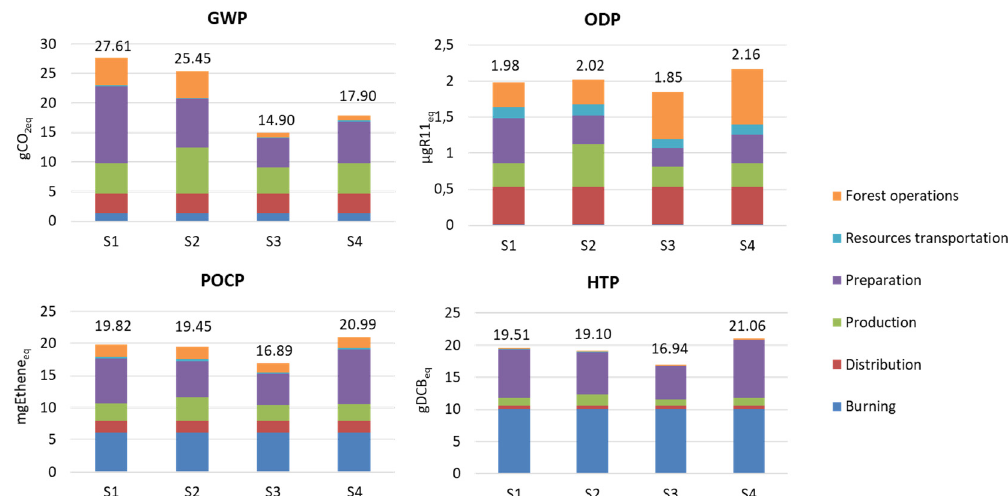
Figure 3. Specific environmental impacts for all four pellet supply chains (S1: pellets from sawmill sawdust; S2: pellets from roundwood; S3: pellets from whole trees, S4: pellets from logging residues) grouped per impact category (GWP: Global Warming Potential, ODP: Ozone Depletion Potential, POCP: Photochemical Ozone Creation Potential and HTP: Human Toxicity Potential).